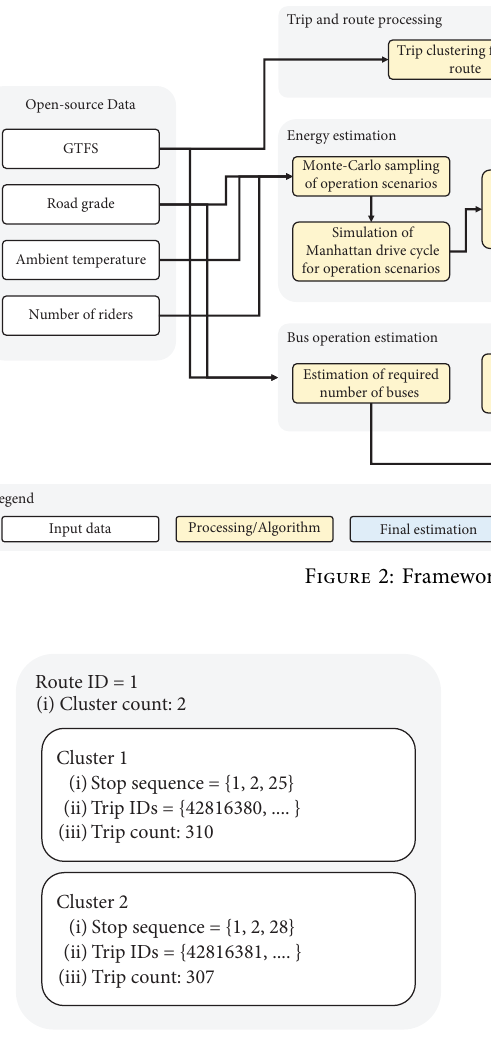
Figure 3: Example of trip clustering for a given